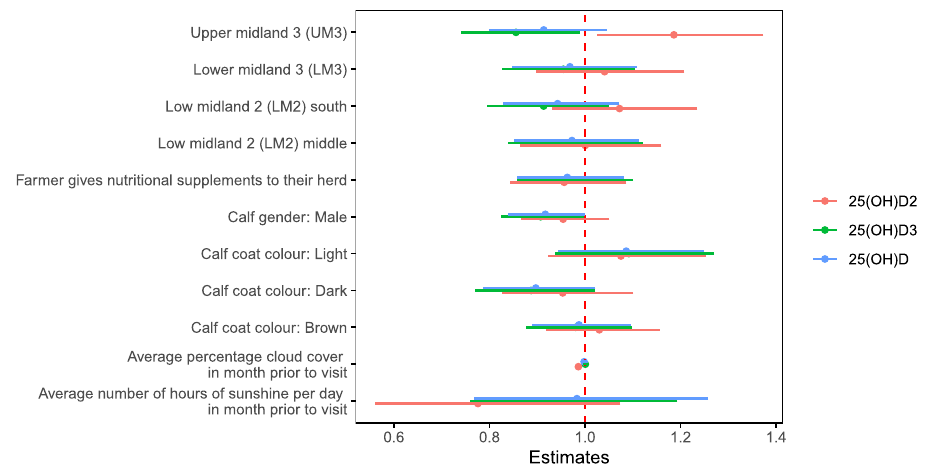
Figure 6. Estimates of effect sizes for the environmental level factors affecting serum 25(OH)D concentration after accounting for the calf level factors. Average model estimates are calculated for variables in the top model set (models with a cumulative Akaike weight ≤ 0.95, Supplementary Table 2 and Supplementary Fig. 3). Error bars represent the 95% confidence intervals. Factors are considered important if their confidence intervals do not span one, as indicated by the dotted vertical line.